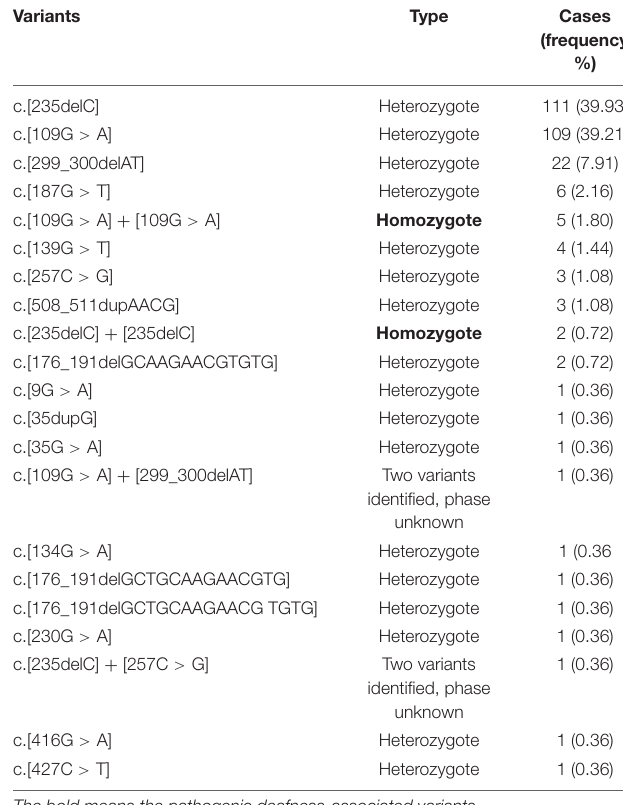
TABLE 4 | 98 SLC26A4 variants and genotypes.